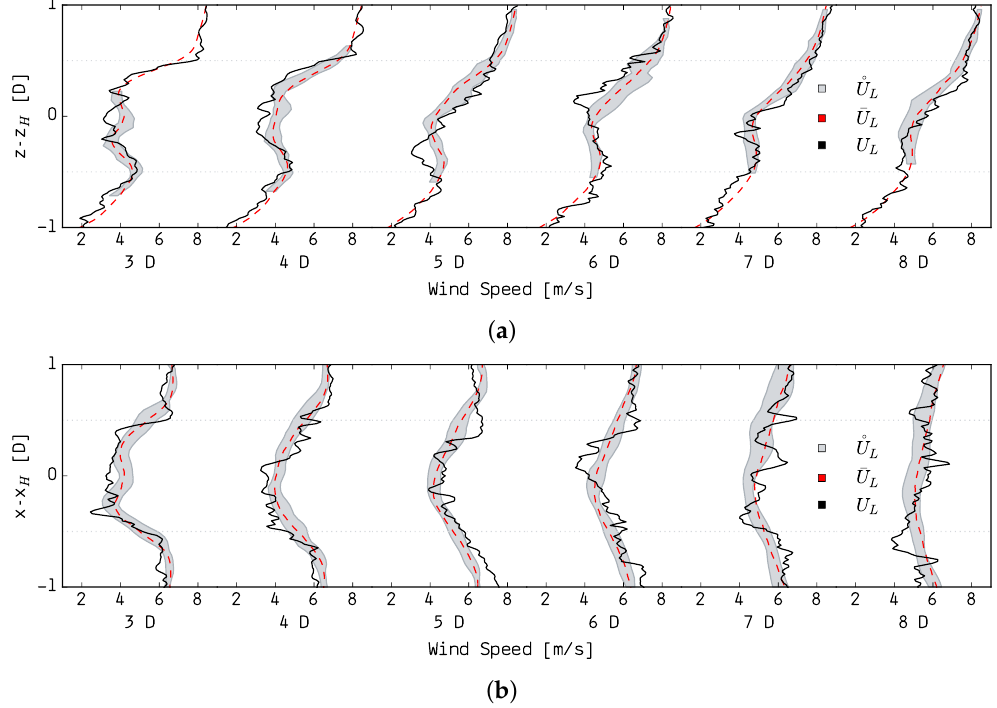
Figure 6. Mean wind speed profiles U L (dashed red) from the large-eddy simulation (LES) over the time it takes to complete a full scan, instantaneous profiles U L (solid black) at the first second of the scan and synthetic scan profiles given as mean ± one standard deviation (shaded gray). ( a ) Vertical profiles; ( b ) horizontal